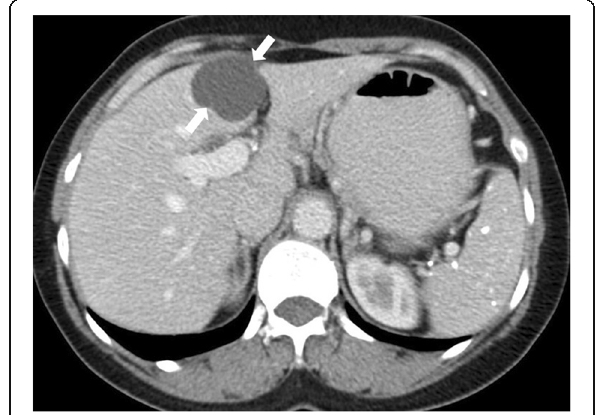
Fig. 12 A 40-year-old female patient with known breast cancer. Axial plane post-contrast CT image shows a unilocular cystic lesion located in the subcapsular area of the segment 4 (arrows). The location was found to be typical for CHFC. The cyst was stable on